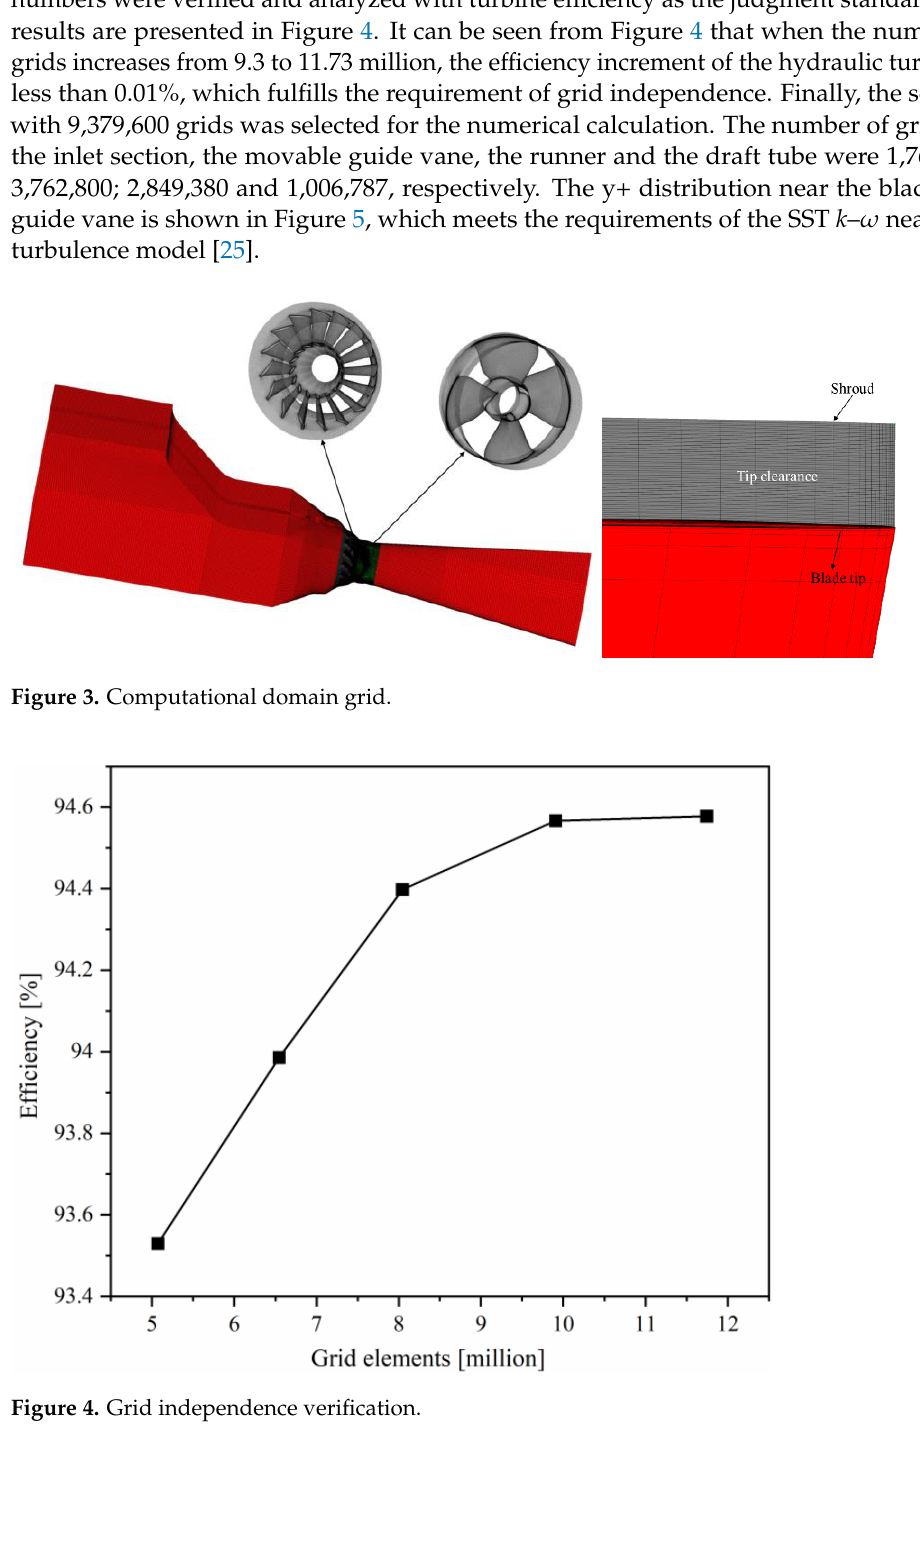
Figure 5. y+ distribution on blade and guide vane surface. Figure 6. Interface between overcurrent components. 3. Numerical Results and Discussion To study the leakage flow and leakage vortex characteristics of the hydraulic turbine under different tip clearances, the unsteady numerical calculation results of three struc- tures with tip clearance δ 1 = 5 mm, δ 2 = 10 mm, and δ 3 = 20 mm were analyzed under the rated flow condition Q r (guide vane opening 55.6° and slurry vane opening 20°).